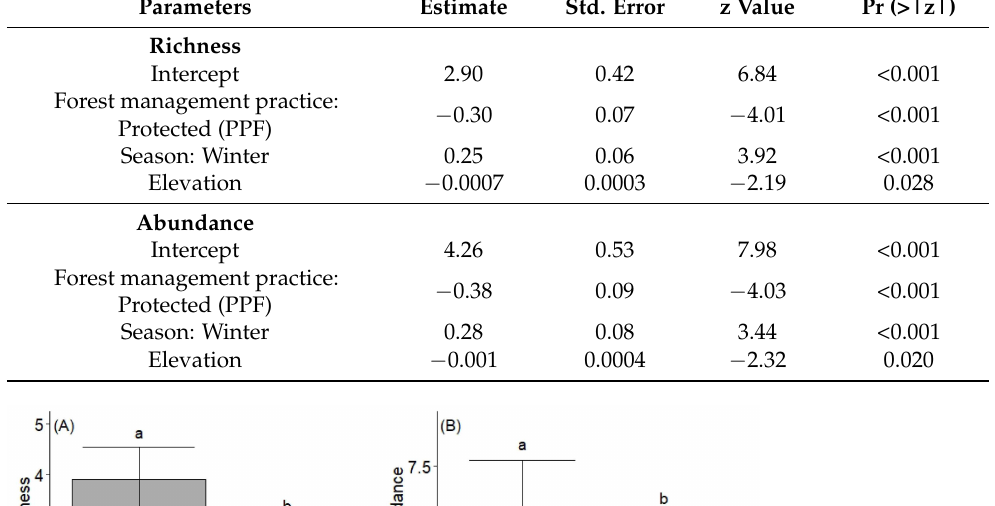
Table 2. Summary of generalized linear model results showing the factors affecting bird species richness and abundance in the mid-hills of Nepal. We used negative binomial distributions due to overdispersion in the Poisson family. The forest management practices included protected forest (Panchase Protection Forest (PPF)) and community forest (Tibrekot Community Forest (TCF)). The protected forest is managed by the government, while the community forest is managed by the community forest users’ group. The seasons included winter and summer. Parameters Estimate Std. Error